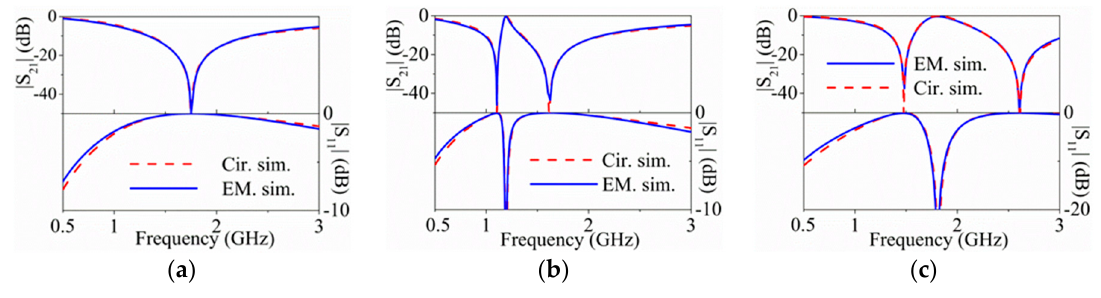
Figure 11. Electromagnetic simulation, and circuit simulation of the structures of Figure 7 with vias connecting the central patch of the 5-SIR and the central strip of the CPW transmission line: ( a ) symmetric; ( b ) asymmetric with one capacitance larger; ( c ) asymmetric with one capacitance smaller.